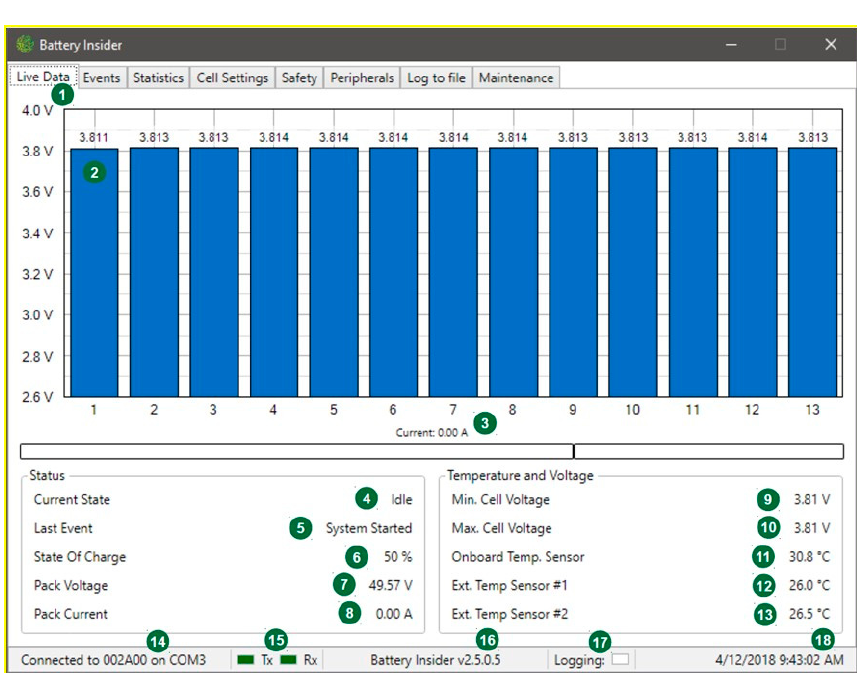
Figure 8. Live data tab parameters.